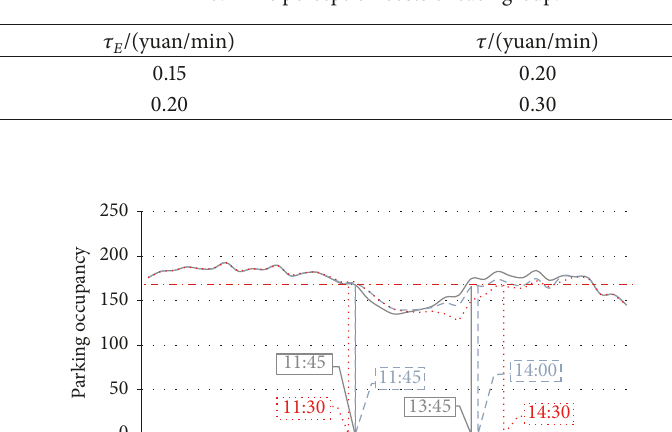
Table 6: Time perception costs of each group.